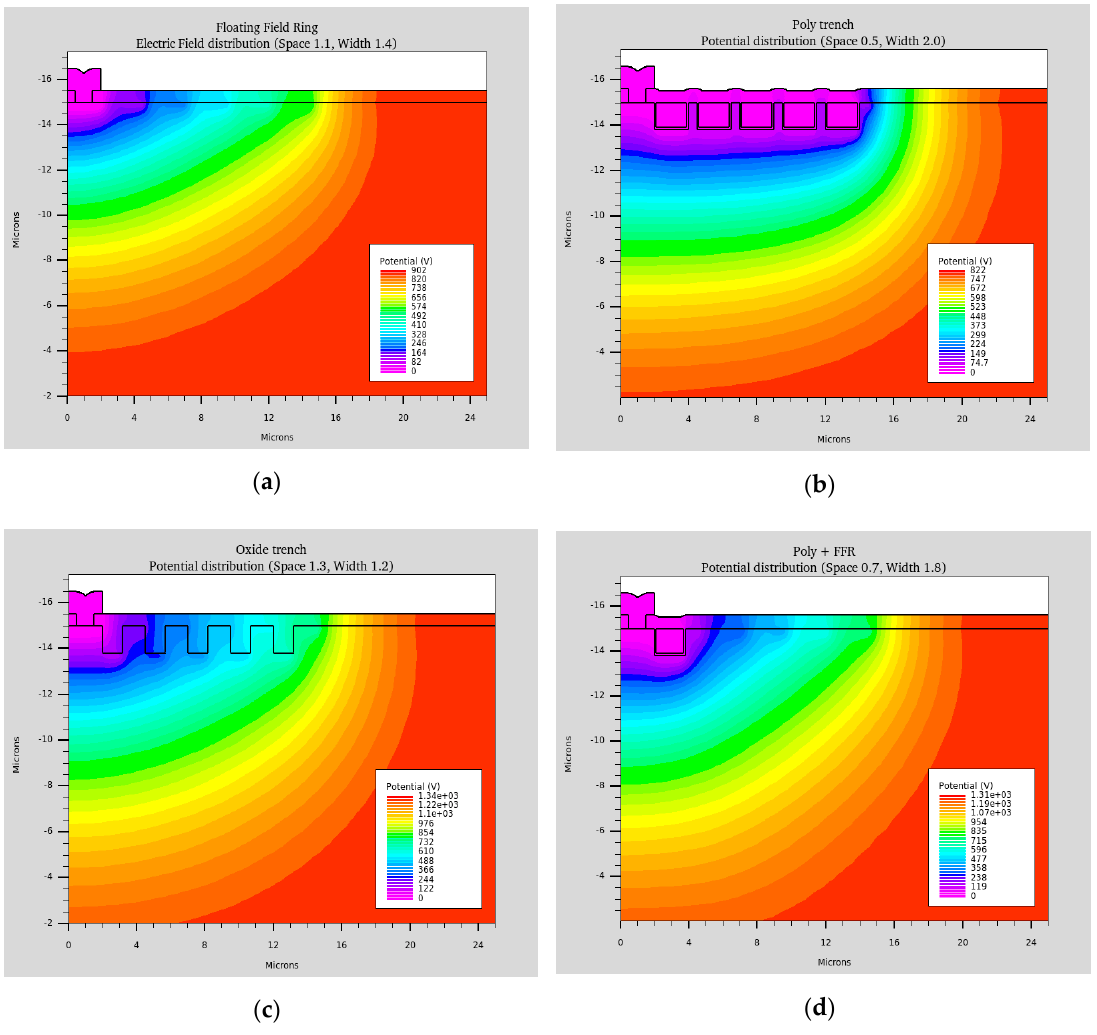
Figure 3. ( a ) Potential distributions close to the breakdown voltage of the conventional FFR